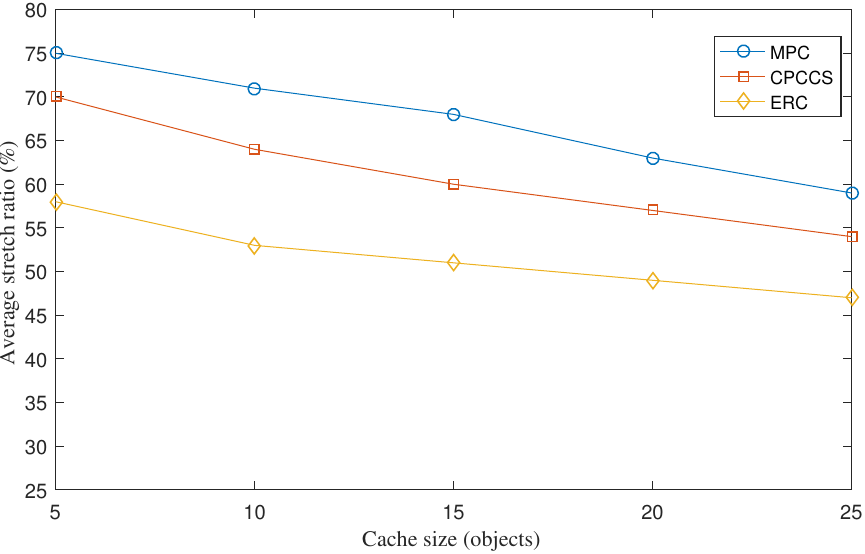
Figure 4. Average stretch ratio under various cache